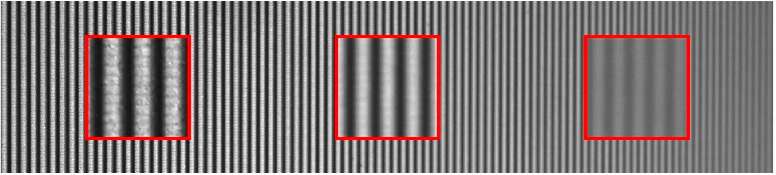
Figure 1. A fringe pattern at different defocusing levels (enlarged in the red box).